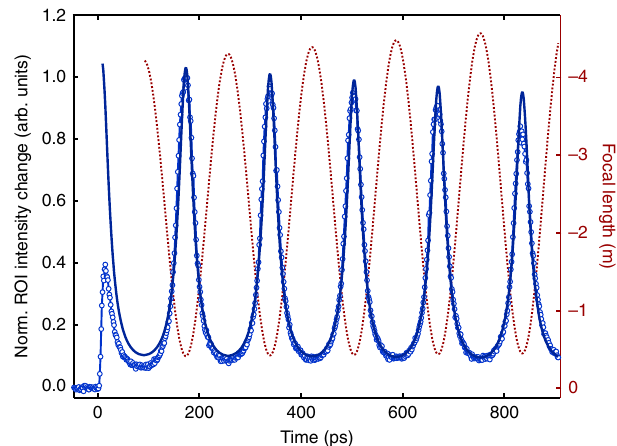
Fig. 7 Comparison between experimental and theoretical electron cyclotron dynamics. The ROI difference intensity trace for ILC = 1.1 A (blue ð Þ (dark blue ð t Þ ¼ Ae (cid:2) t = τ = σ 2 circles, left axis) is fi tted to the function 1 = f EG T t line), where A and τ are phenomenological fi tting parameters encompassing the time-dependent number of electrons in the cloud and TEM-speci fi c lens settings. σ T is the time-dependent transverse radius of the electron gas, which depends on the velocity spread σ v , the minimum radius σ r , and the cyclotron angular frequency ω (all fi tted to the data). The fi tting range is 100 – 900 ps, i.e. beyond the regime where Coulomb interactions are signi fi cant. The corresponding focal length of the electron gas, f EG , is plotted in red (right axis), which is only an order-of-magnitude estimate due to the approximations in the model (see text).